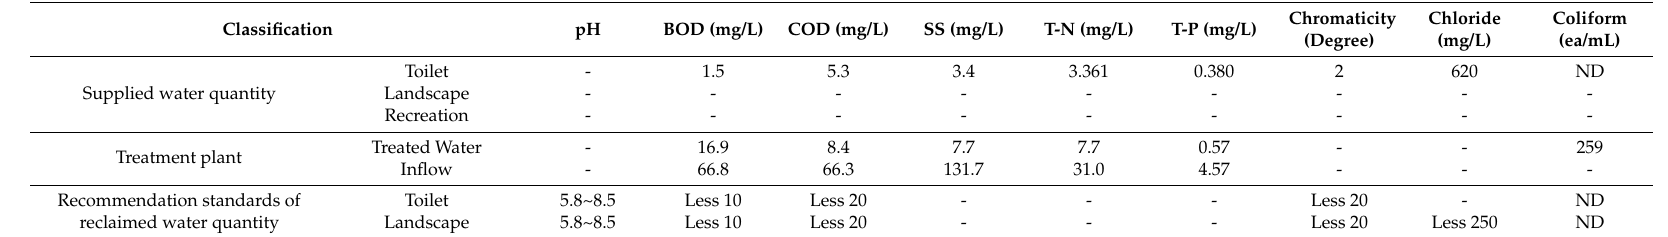
Table 2. Properties of Reclaimed Water